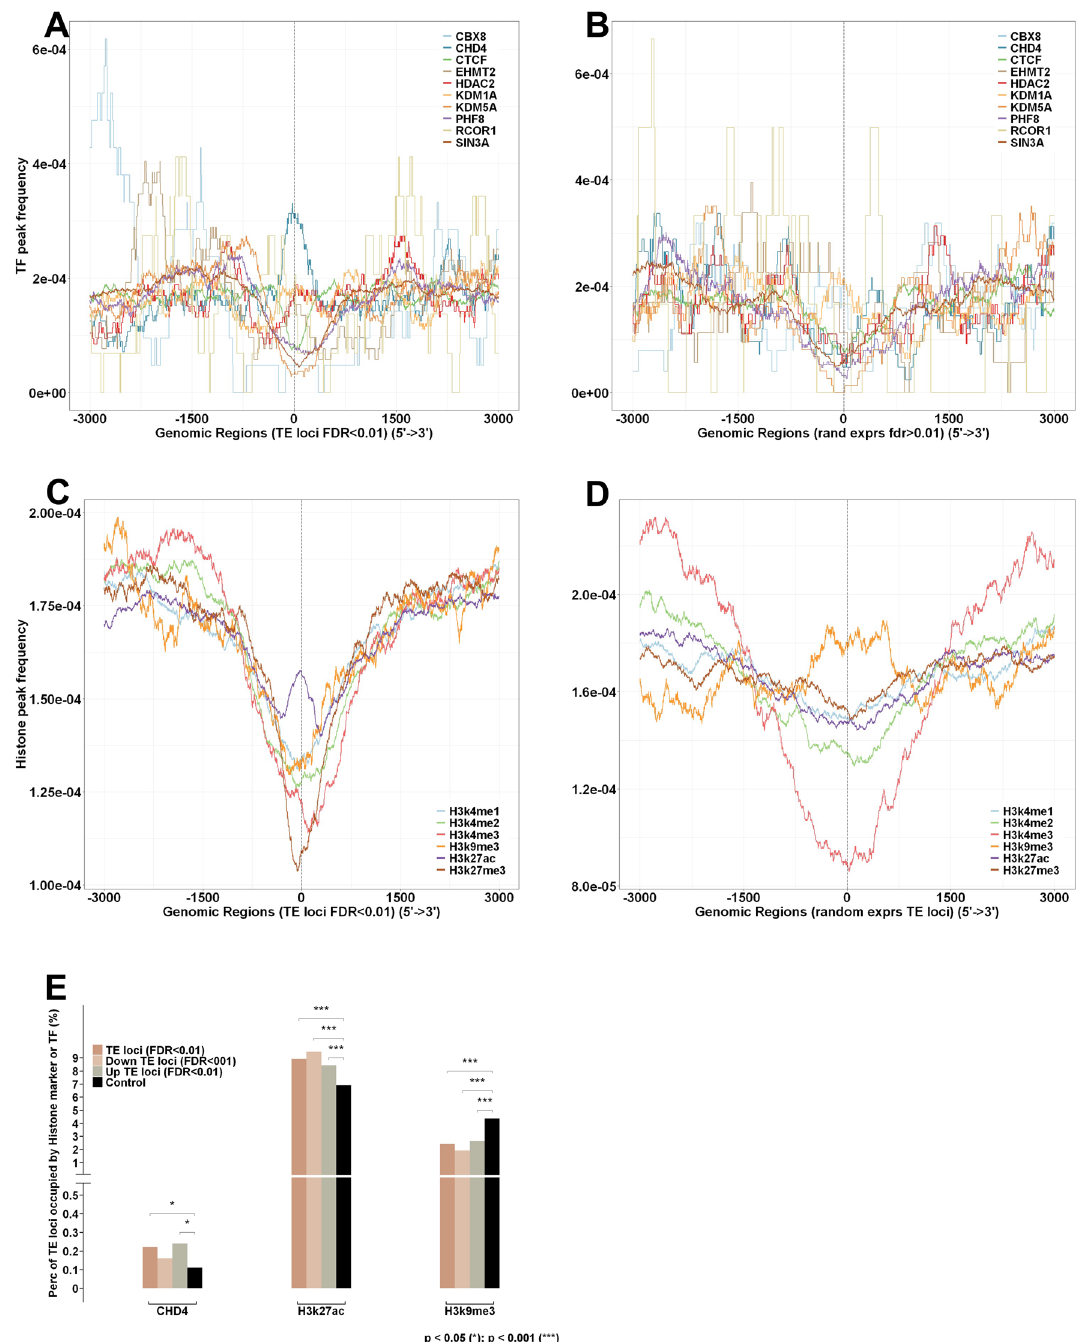
Figure 2. The spatial relationship between the DE TE loci and CHD4 binding sites, H3k27ac and H3k9me3 abundant regions. ( A ) CHD4 binding sites are more enriched in the DE TE regions (FDR < 0.01) than other 9 remodelers; in contrast to ( B ) non-DE TE regions (FDR > 0.01). ( C ) H3k27ac is abundant in the DE TE loci. ( D ). H3k9me3 is abundant in the non-DE TE loci. ( E ). Chi-square test demonstrated that the enrichment of CHD4, H3k27ac and H3k9me3 in the DE TE regions is statistically significant, which random selected TE loci (black) is H3K9me3 peak regions. The higher percentage of non-DE TEs that overlap H3K9me3 peak regions suggests that more TEs are suppressed by H3K9me3 in the genome prior to virus infection in comparison to post-infection. H3K27ac is thought to be an epigenetic marker for enhancers in mammals, and its modification reflects cell type specific gene expression 19,20 . A recent study has shown that the enhancer activity cannot be determined by H3K27ac alone 21 . These findings suggest that H3K27ac likely works with other chromatin proteins to main- tain poised chromatin status in its abundant regions. In our analysis, of the 2825 overall CHD4 binding sites,